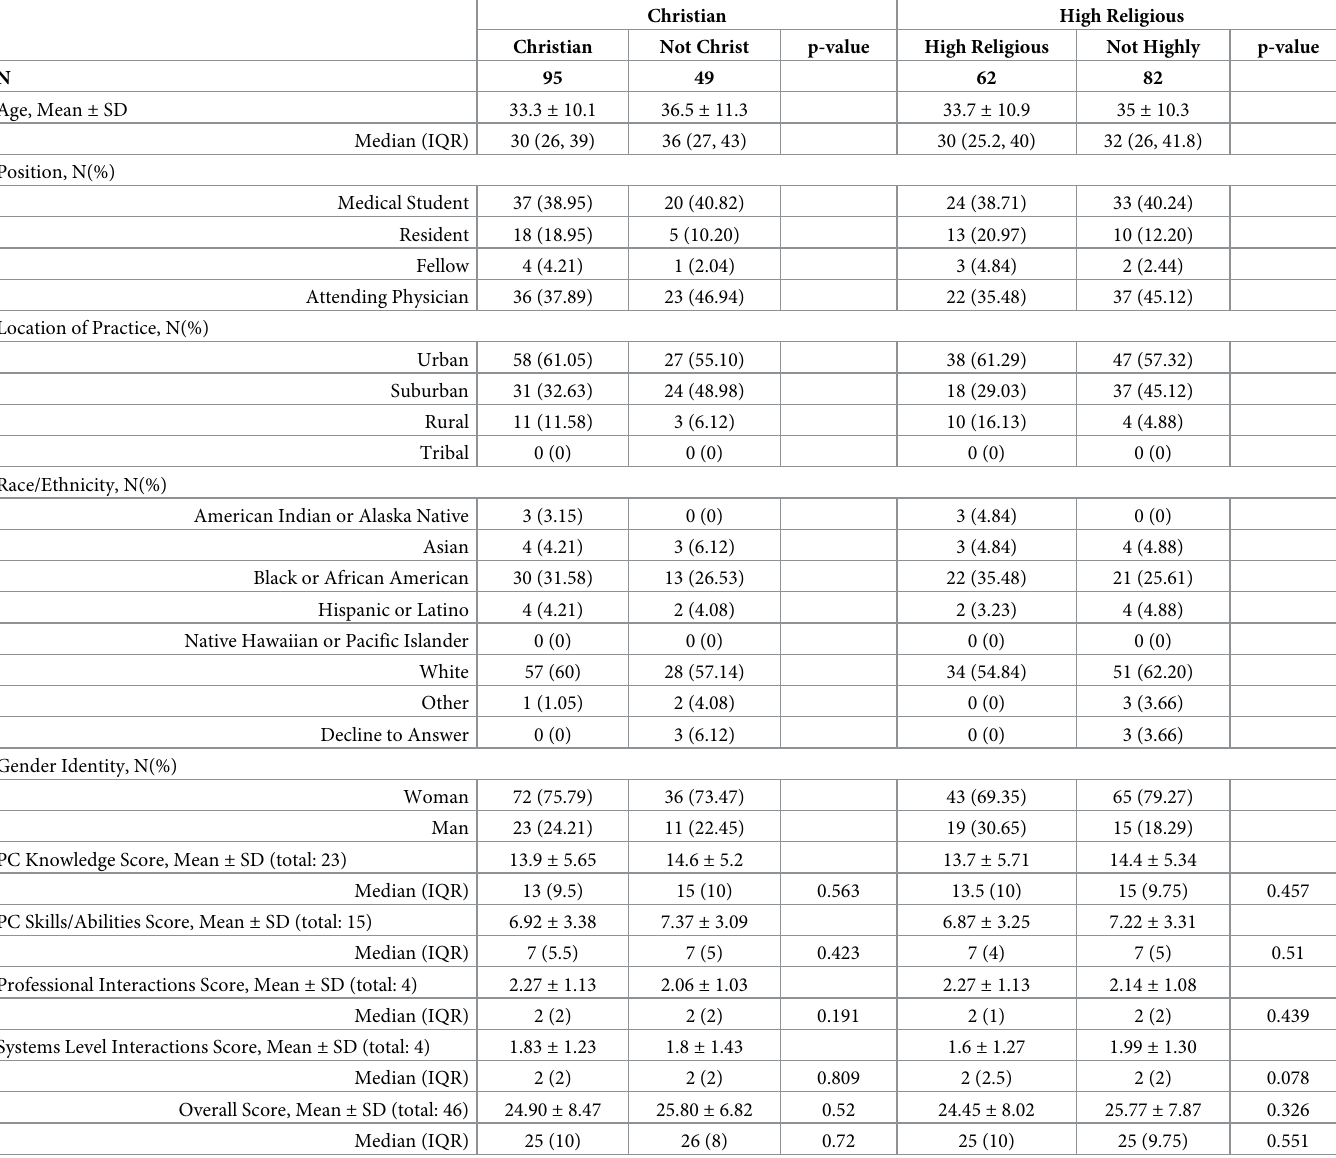
Table 3. Demographic data and total score comparisons for each of the groups: Christian versus non-christian and HR versus